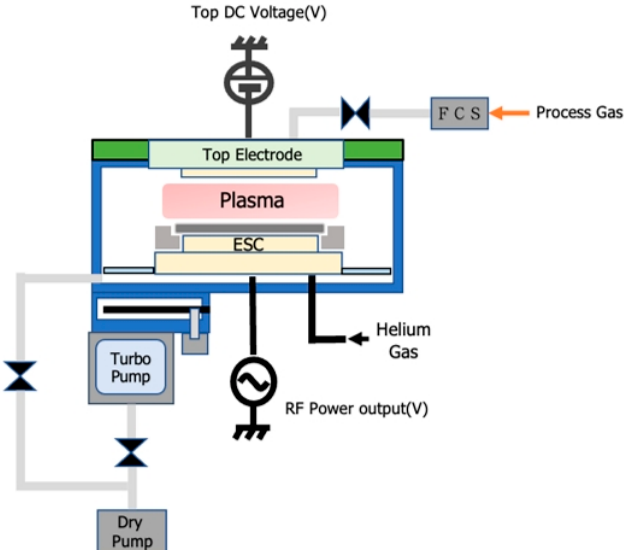
Figure 2. Diagram of the adopted capacitive coupled plasma dry etching system.